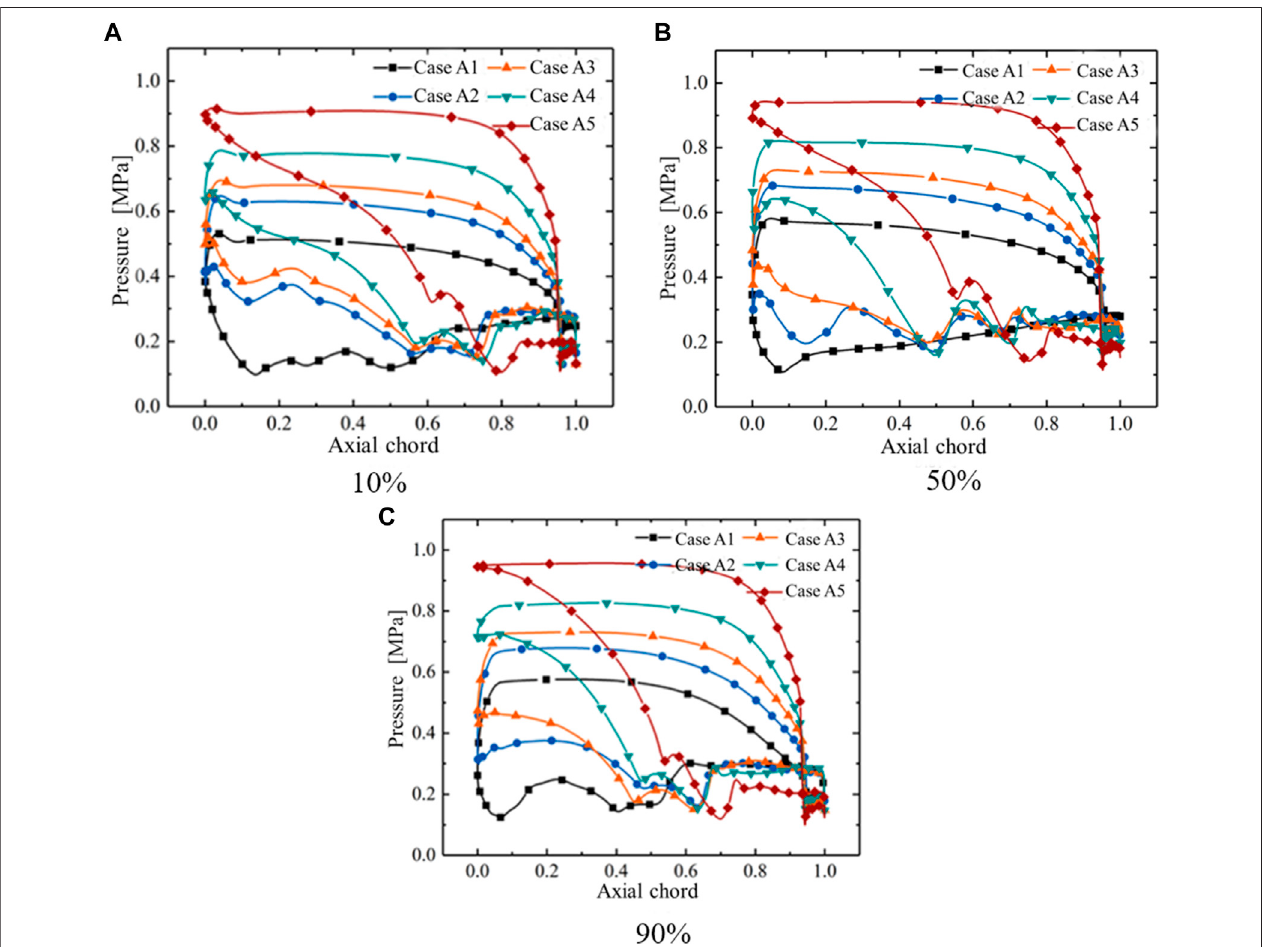
FIGURE 10 | Blade surface pressure distribution of rotor from Case A1 to Case A5. (A) 10%. (B) 50%. (C) 90%.